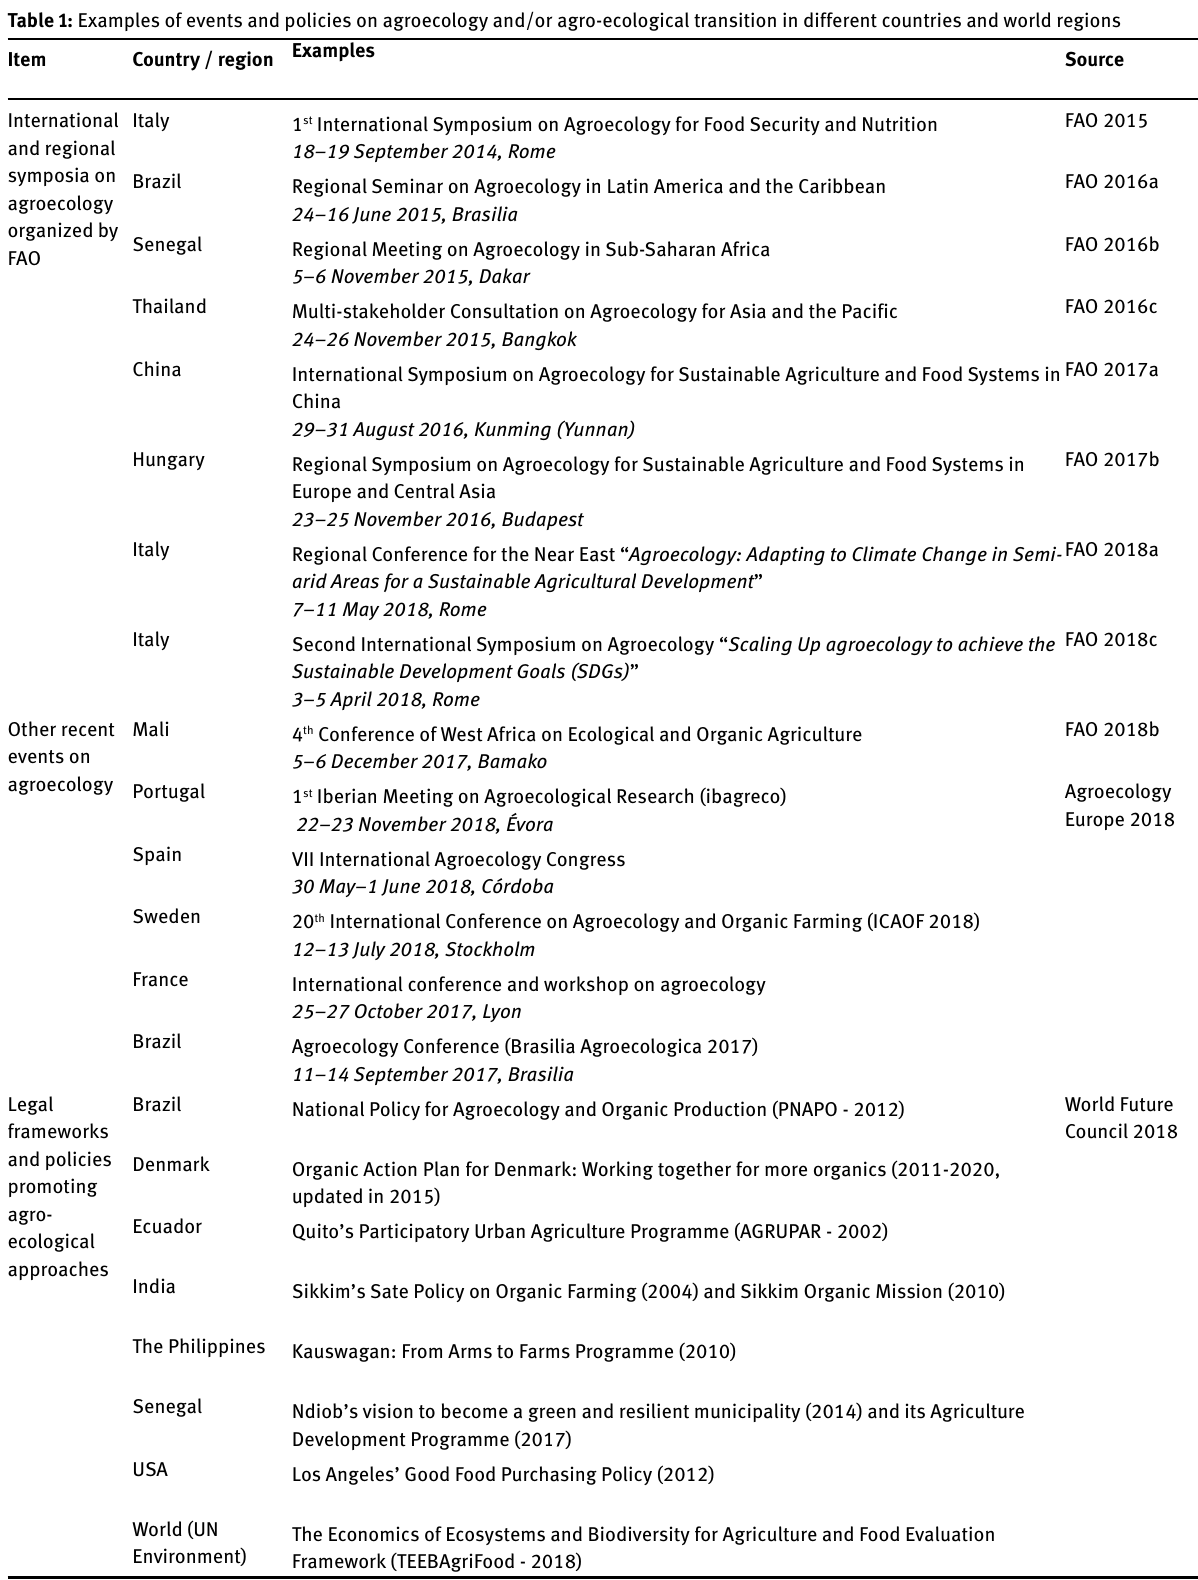
Table 1: Examples of events and policies on agroecology and/or agro-ecological transition in different countries and world regions